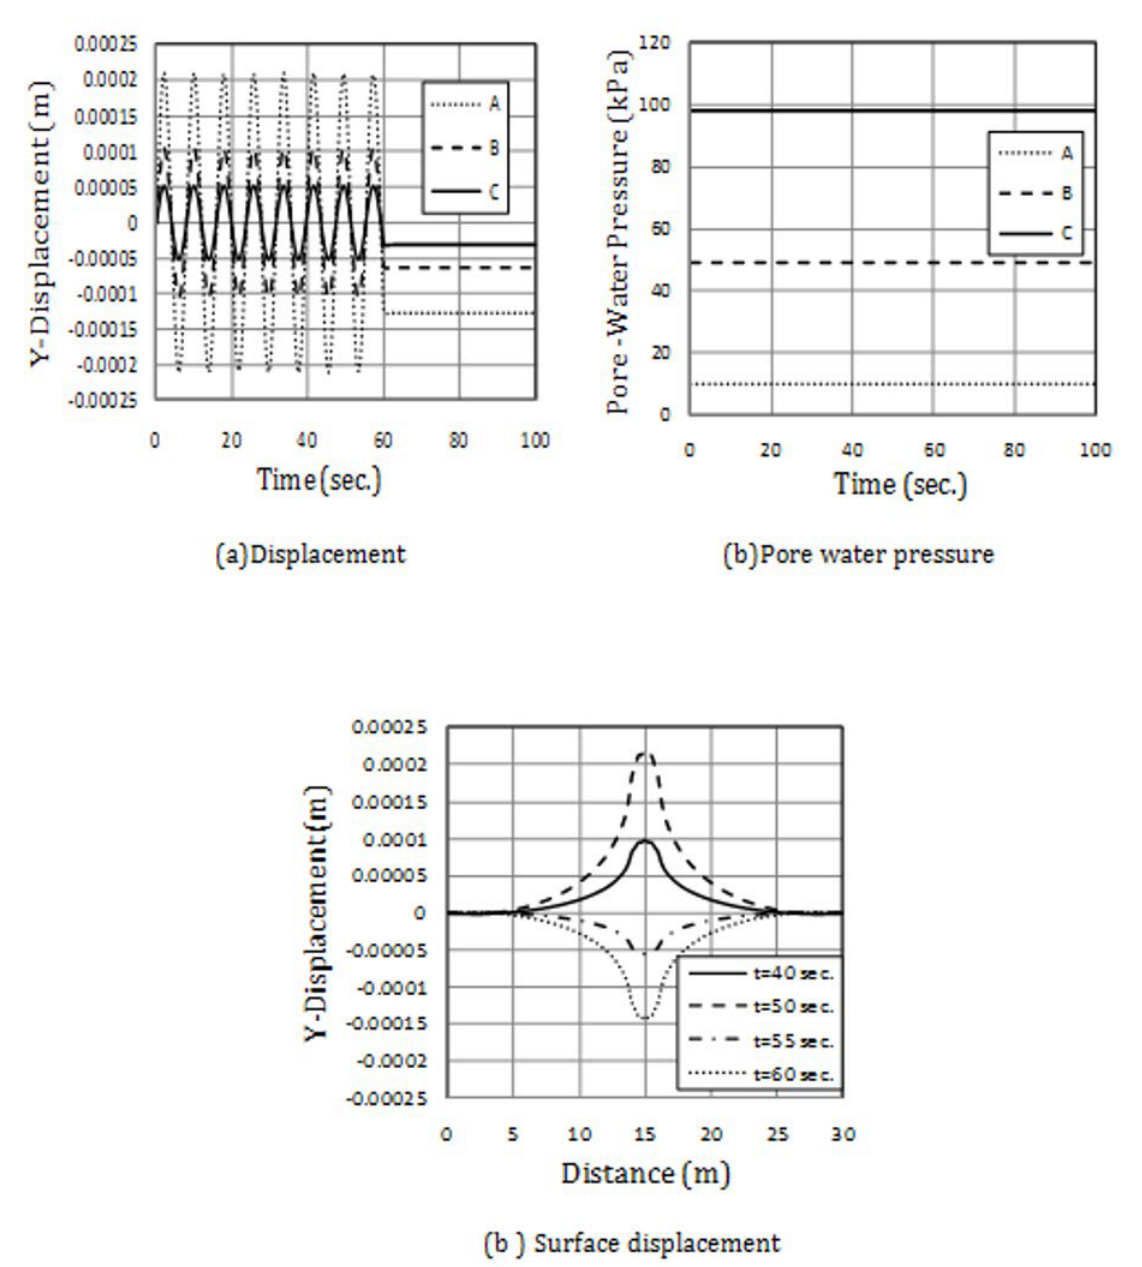
Figure 13. Dynamic response of the foundation to harmonic load, a